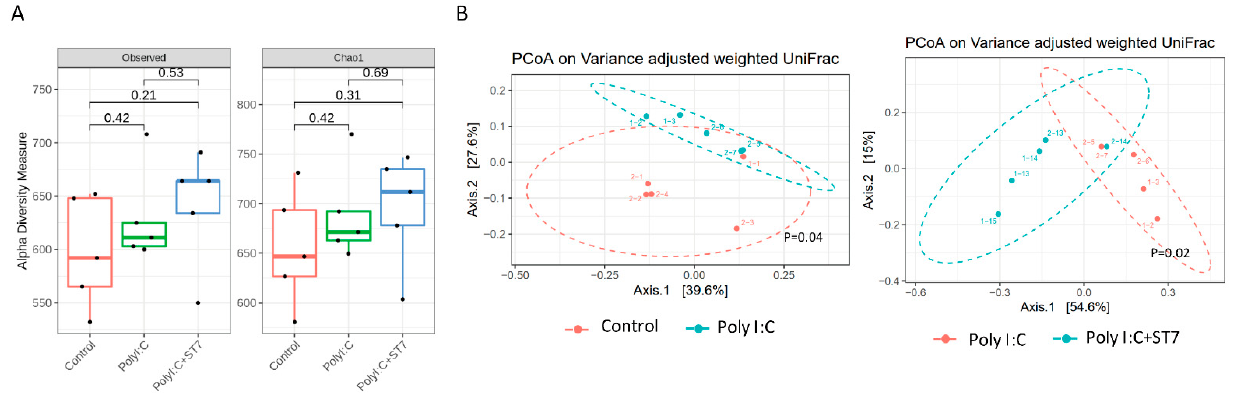
Figure 4. ST7 treatment modulates the distribution of the fecal microbiome after poly I:C stimulation. Fecal microbiome profiling was performed using high-throughput sequencing of the 16S ribosomal ribonucleic acid gene. ( A ) Alpha diversity of fecal microbiota and ( B ) principal coordinate analysis plots (obtained using variance-adjusted weighted UniFrac analysis) for the control, poly I:C, and poly I:C+ST7 mice. Permutational multivariate analysis of variance (vegan::adonis, 1000 permutations) revealed a considerable difference in beta diversity, which was quantified using the betadisper function (vegan::betadisper, 1000 permutations). Both adonis and betadisper indices yielded p values of <0.05 and >0.05, respectively.